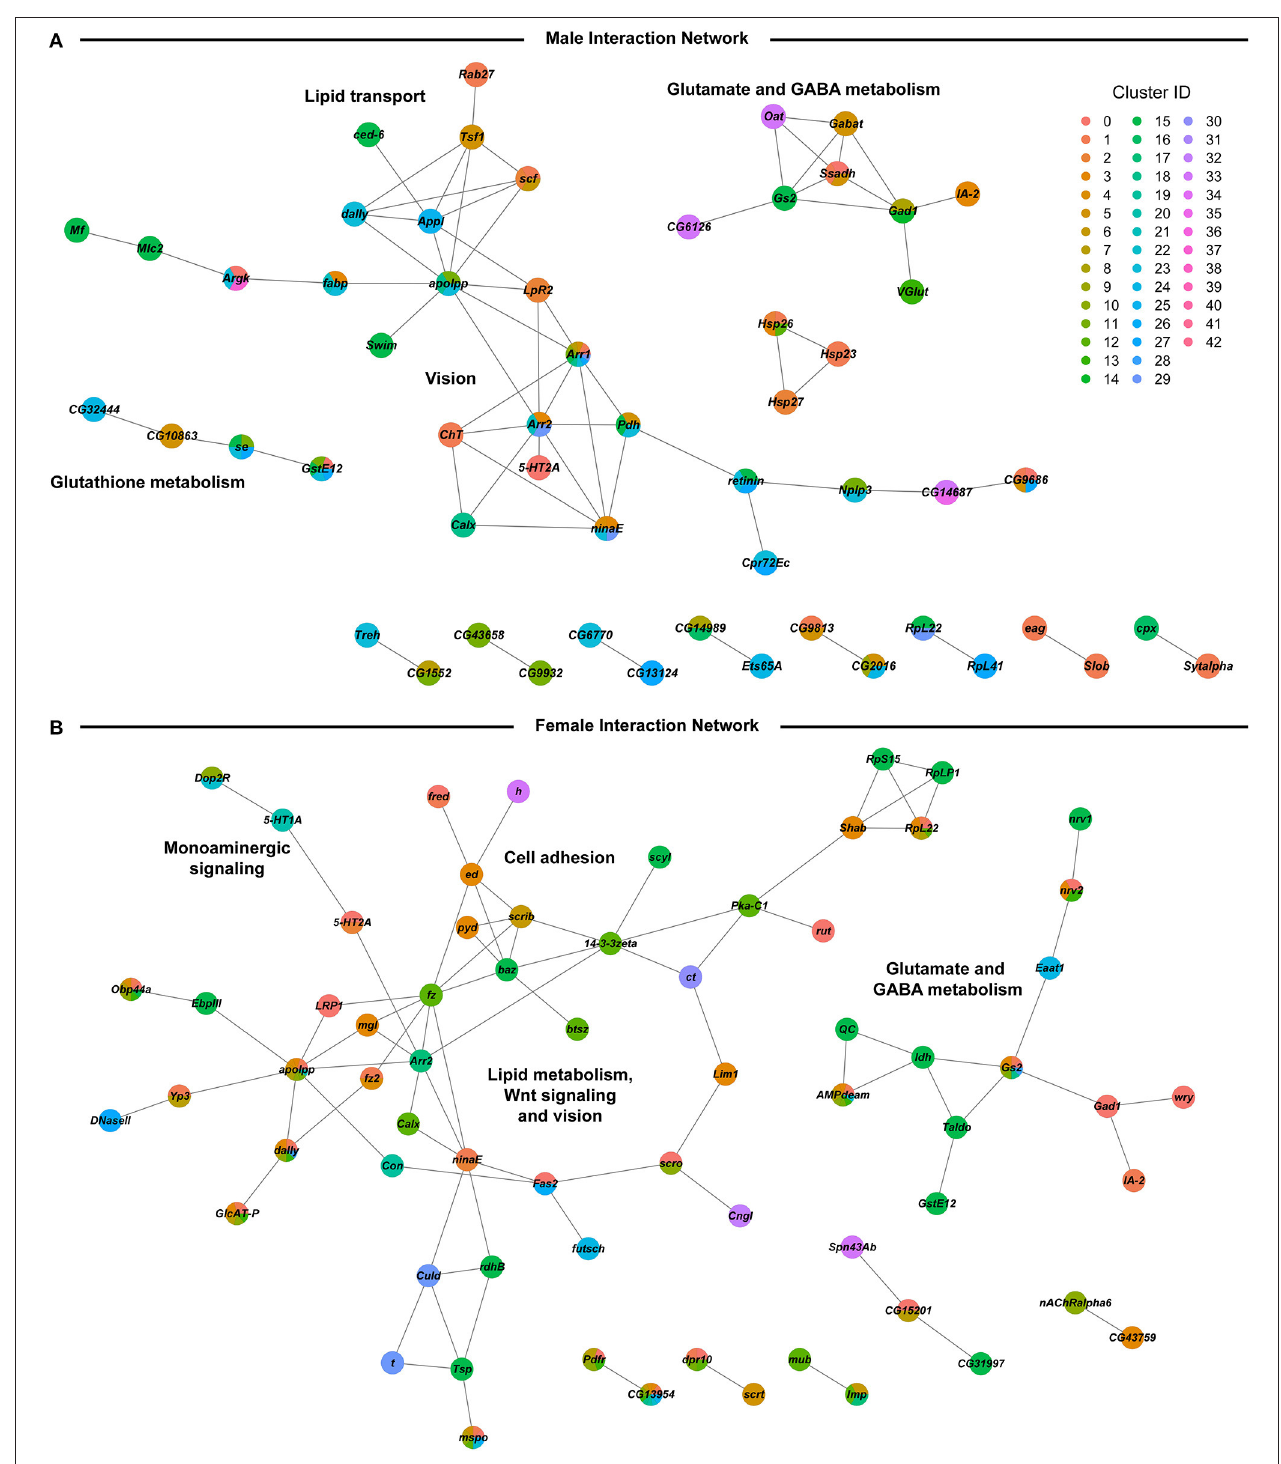
FIGURE 6 | Global interaction networks of differentially expressed gene products in males (A) and females (B) following developmental alcohol exposure. Colors of the nodes correspond to the clusters in which expression of the gene is altered after growth on alcohol-supplemented medium.